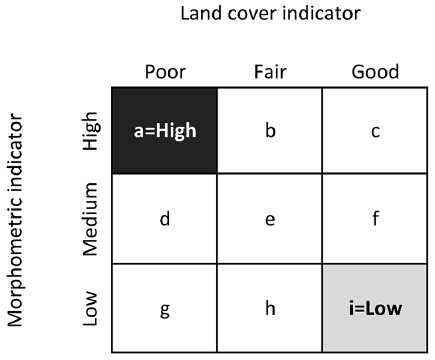
Figure 3. Matrix of classification of